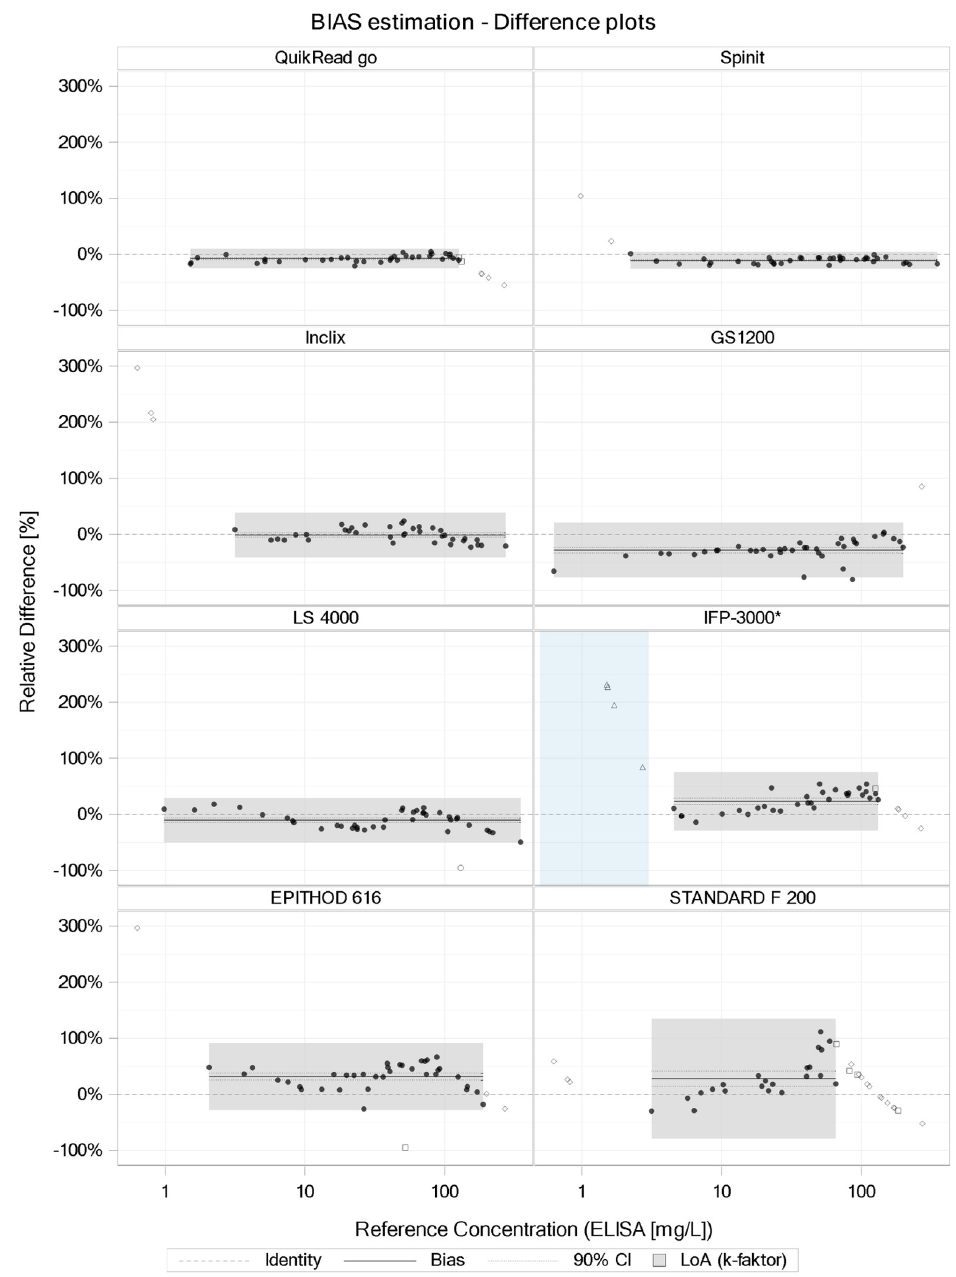
Fig 3. Bland–Altman plots for quantitative tests. Bland–Altman plots comparing CRP POC test results measured using the various quantitative index tests and CRP results measured using the reference method (RM). The X-axes depict the CRP values of the RM, and the Y-axes depict the relative difference between CRP results measured by the POC test under study and the RM. The thick black lines represent the bias and the dotted line its 90% CI; the LoA are represented by the vertical expansion of the gray areas, their horizontal range covers the observed concentrations within AR of the respective index method � . Black dots represent samples included in the analysis, while the other symbols represent excluded data points (values out of AR and outliers). Note: For Standard F200 and IFP-3000, the assumption of concentration-independent relative bias, which is essential for the validity of the BA plot analysis, is questionable. � For IPF3000, three samples were excluded in the low concentration range ( < 3 mg/L) to achieve constant CV (variance homogeneity) in the analyzed range. As a consequence, the lower limit of the AR is approximately 4 mg/L and not 0.5 mg/L (denoted by the light-blue area in the figure).